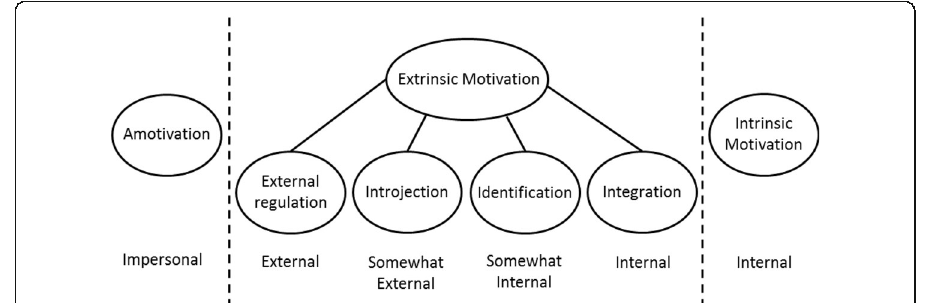
Fig. 2 A Taxonomy of Human Motivation, adopted from Ryan and Deci